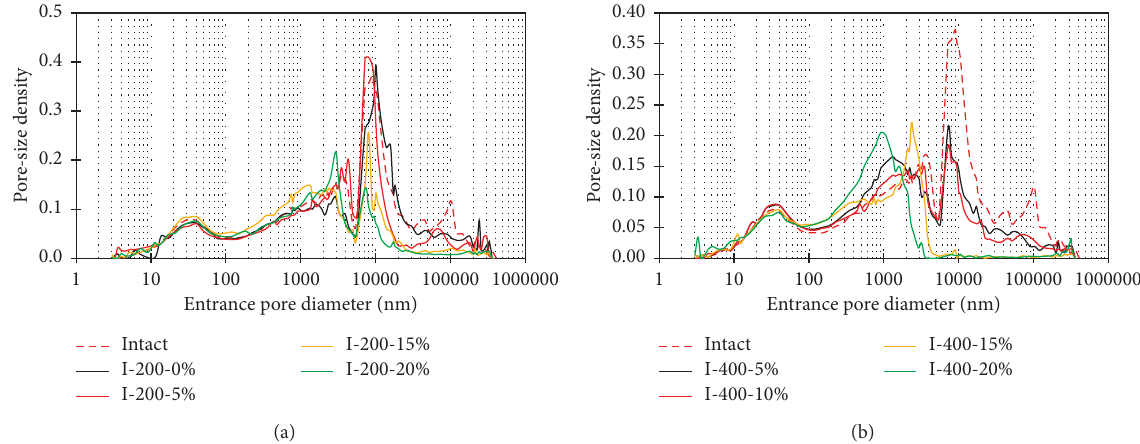
Figure 11: PSDs of intact loess specimens sheared to sequential axial strains under the confining stress of (a) 200kPa and (b) 400kPa.